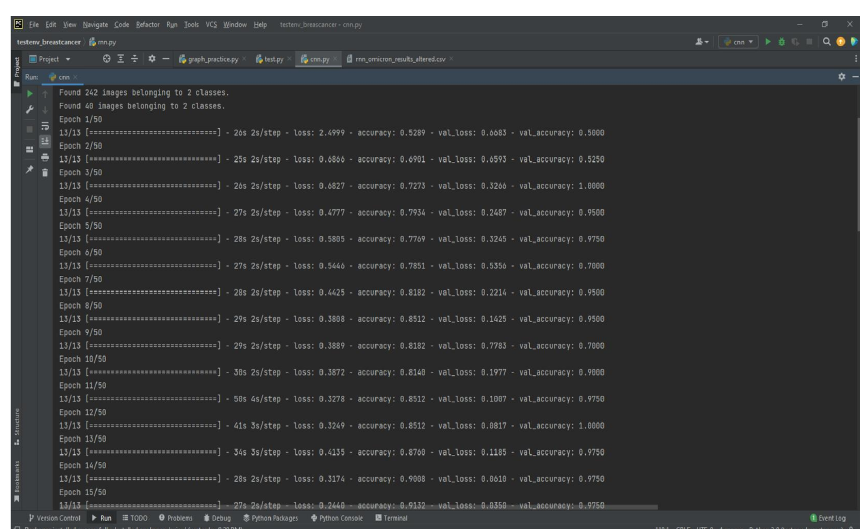
Figure 11: ECNN code performance stream.